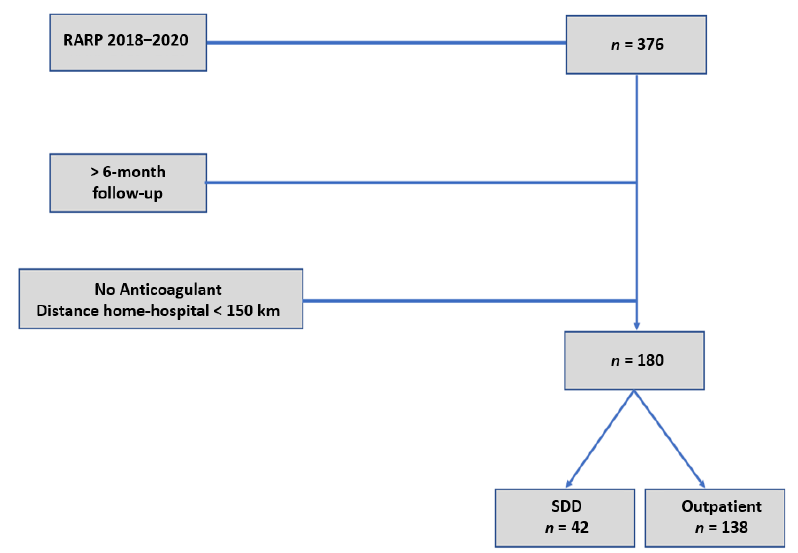
Figure 1. Flowchart of study design. RARP: robot-assisted radical prostatectomy; SDD: same day discharge.